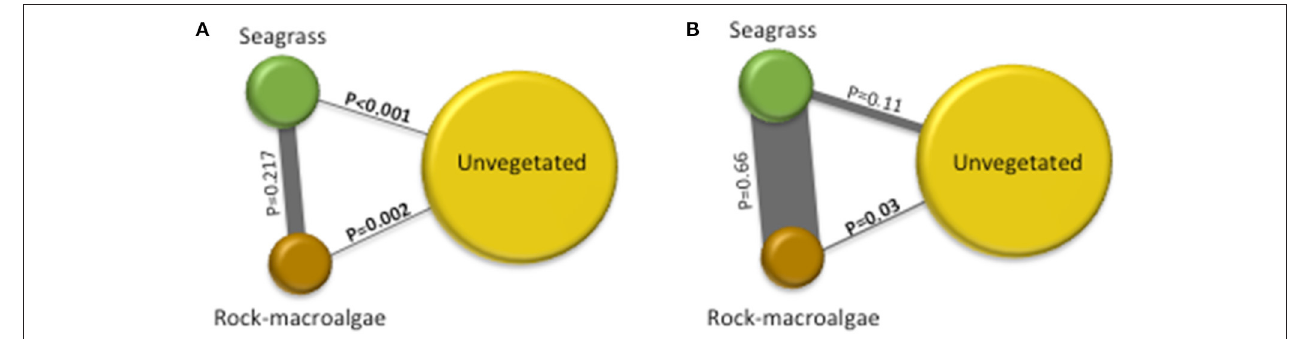
FIGURE 2 | The illustration is based on pairwise post-hoc (Tukey’s test) results from randomized block-designed ANOVAs comparing fish abundance per m 2 in the three studied habitats. The size of the circle is proportional to the average size of the habitat area for all six seascapes. The lines between the habitats are proportionally related to the strength of the similarity between habitats; the thicker the gray line is the more similar the fish abundance is between those habitats. Significant differences between fish abundances in different habitats are indicated by bolded p -values (where p < 0.05). No differences were found between sites with p = 0.09 for illustration (A) and p = 0.179 for (B) . * Clupea harengus abundance was removed from the analysis in the image on the left (A) and included in the image on the right (B) .